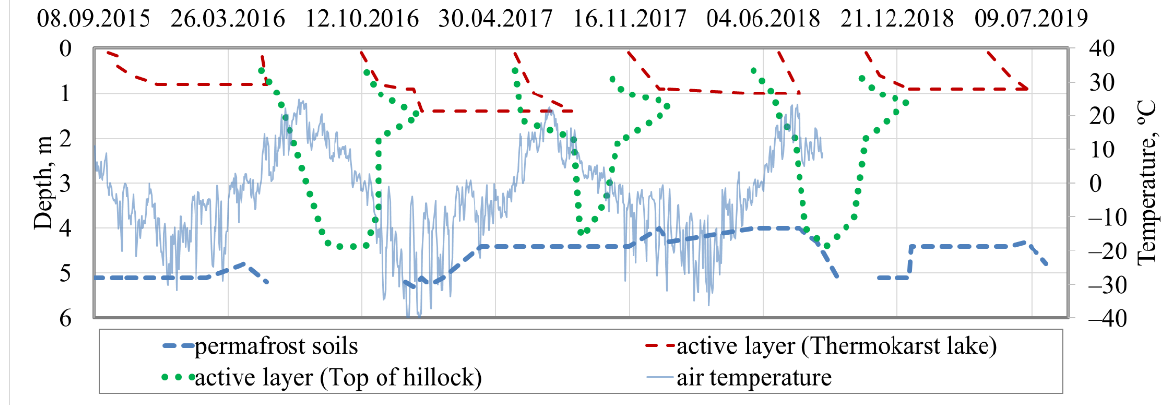
Figure 9. Changes of active layer thickness and depth of permafrost at the boreholes Khanovey-1 and 3 (air temperature was recorded from our local temperature sensor).